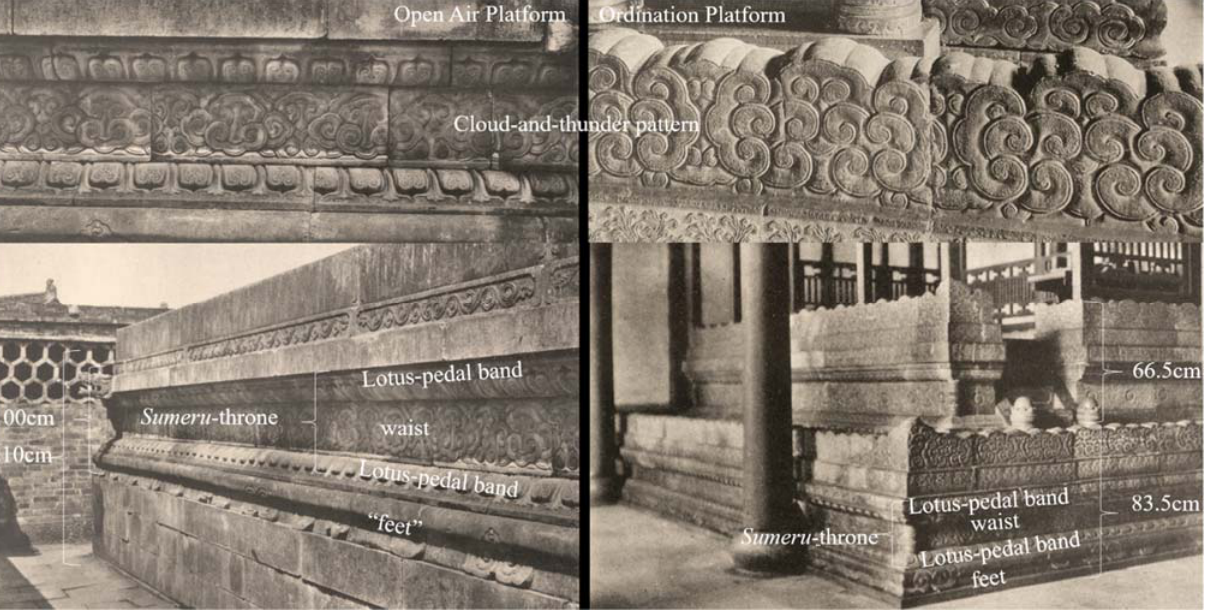
Figure 18. A comparison between the Open ‐ Air Platform ( left ) and the Ordination Platform ( right ), with author’s annotations (drawing by author, based on Prip ‐ Møller 1937).